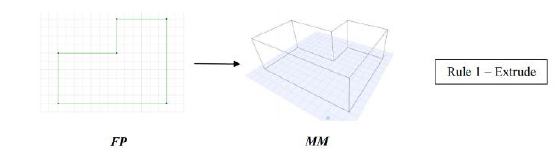
Figure 9. Rule 1 - extrudes a building footprint